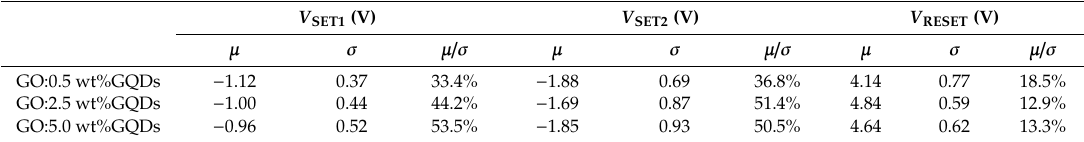
Table 3. Values µ and σ of the SET1, SET2 and RESET voltages ( V SET1 , V SET2 , and V RESET ) based on ternary memory